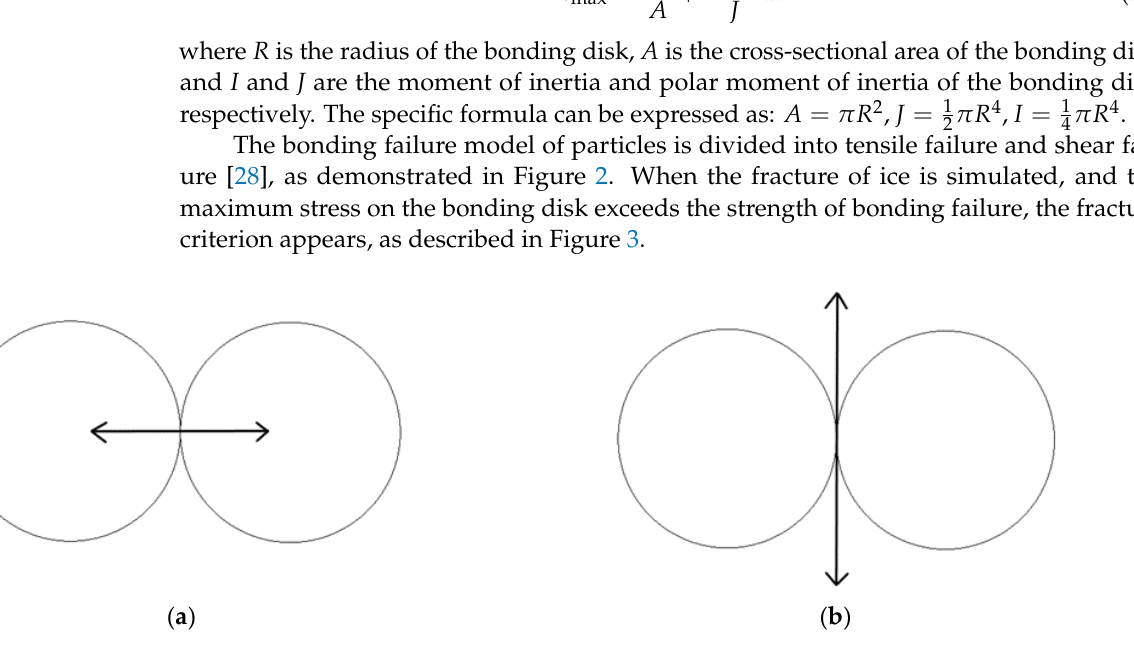
Figure 2. Bonding failure model of particle element. ( a ) Tensile failure; ( b ) shear failure.